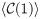
Concavity of the average traded volume v semester s.The black dots—with the black line as a guide to the eye—represent the values of the concavity averaged over companies normalised by the value of 〈C(1)〉; the horizontal lines signal the average value (computed over all companies and semesters) and the upper and lower error limits. It is clear the concavity of the average traded volume has diminished.